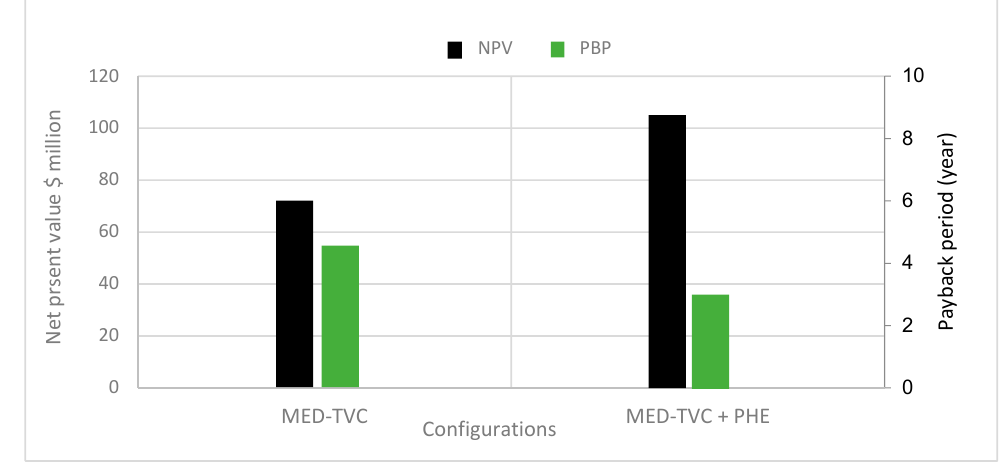
Figure 11. Payback period (PBP) and net present value (NPV) for both modes in proposed desalination system.